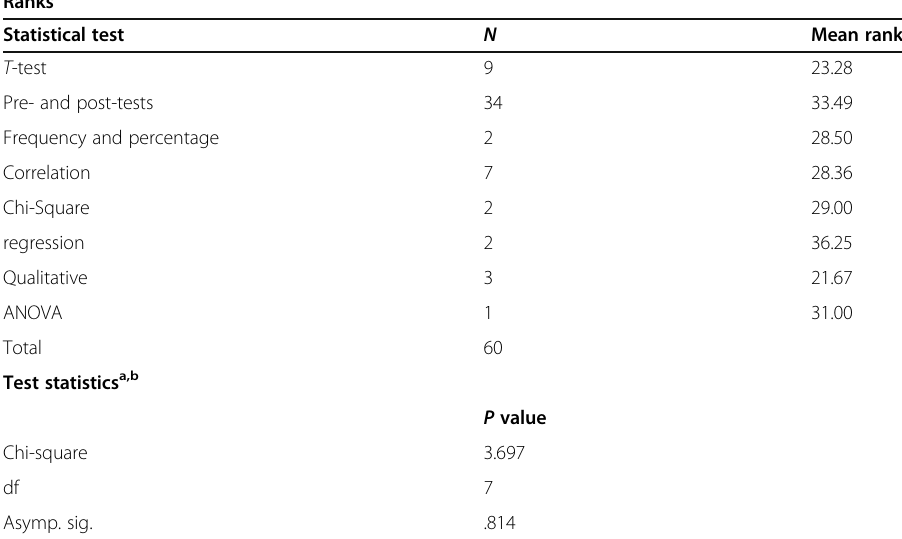
Table 16 Kruskal-Wallis test